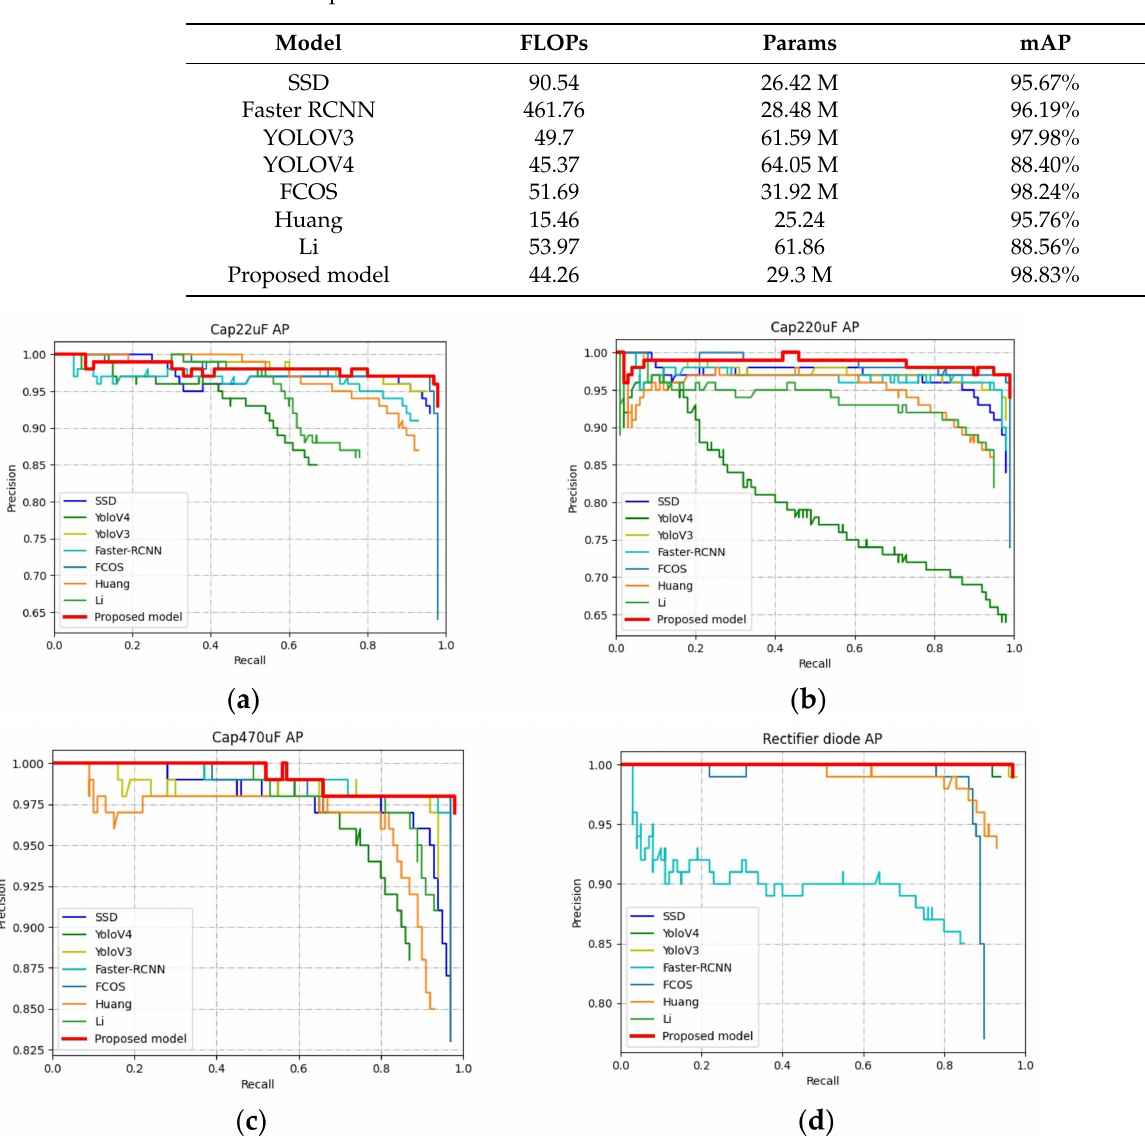
Table 3. mAP values, FLOPs and Params of the proposed model and other models on the multi-scene electronic component test set.